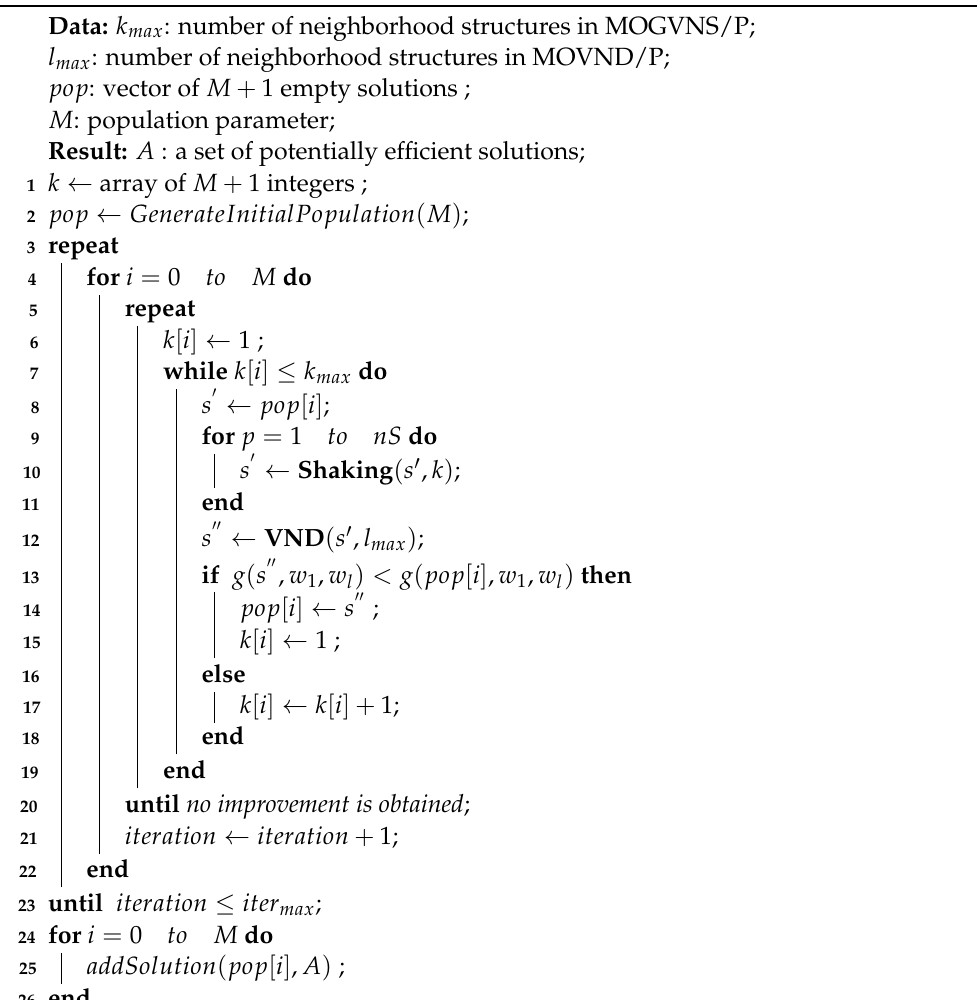
Algorithm 7: Multi-objective General Variable Neighborhood Search based on Decomposition